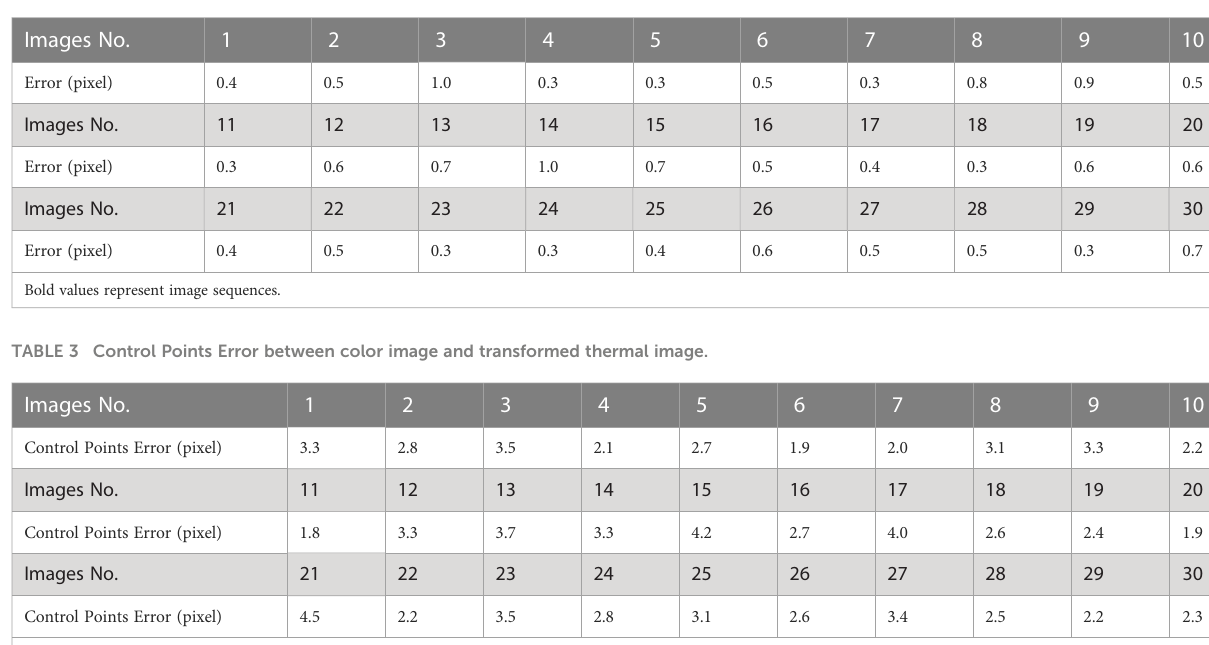
Bold values represent image